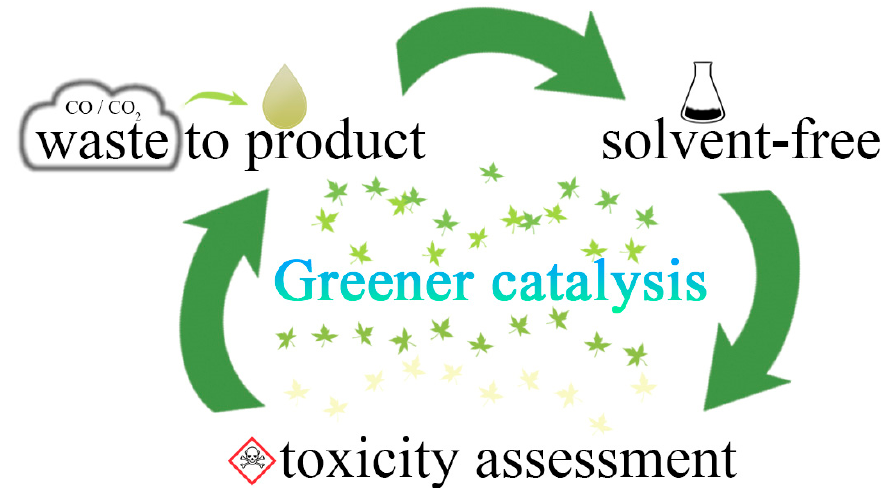
Figure 1. Scheme presenting the main topics that concern greener catalysis and were addressed in this Special Issue.